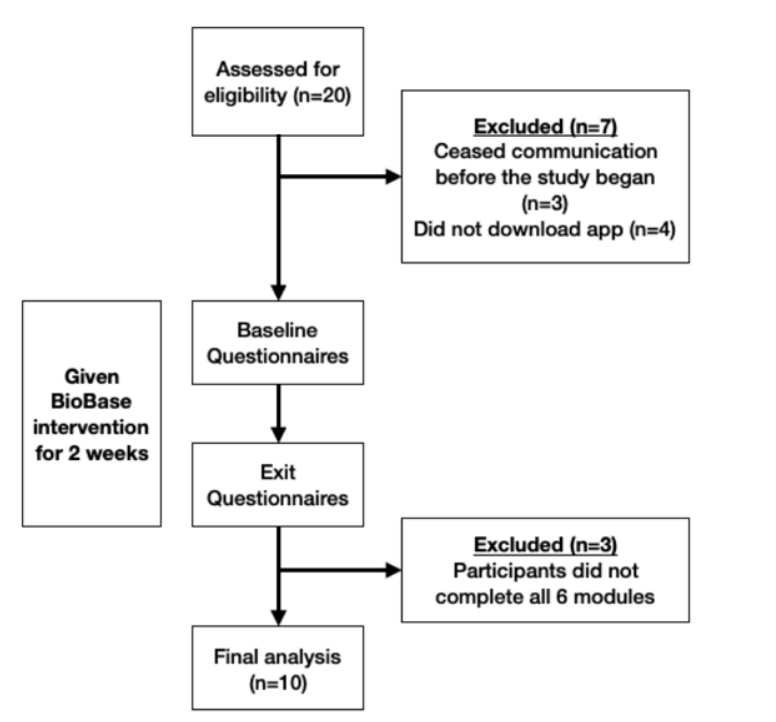
Figure 1. Study flow chart.